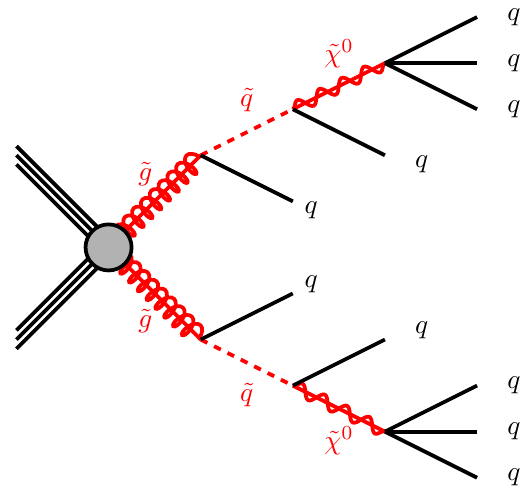
Figure 3 . Schematic Feynman-like diagram for RPV